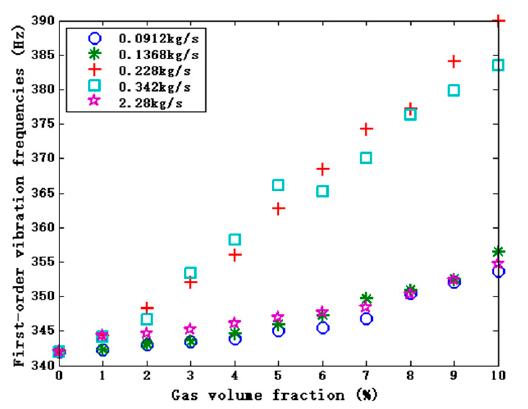
Figure 4. The simulation results of flow patterns relative to basic working mode vibration frequencies of the measuring tube.